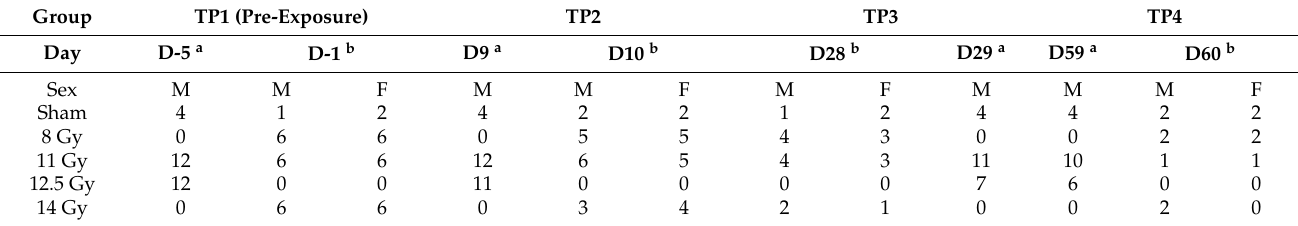
a Samples collected in 2016, males only b Samples collected in 2017, males and females Abbreviations: D, day; F, female; M, male; TP, time